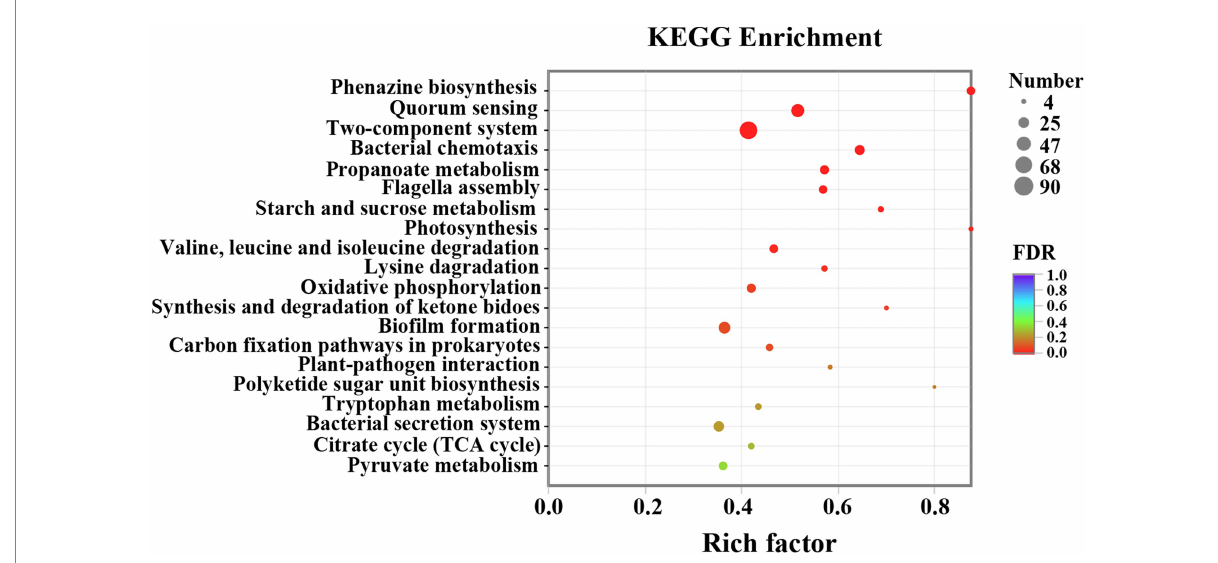
FIGURE 8 KEGG enrichment analysis of P. aeruginosa PAO1 after thymoquinone